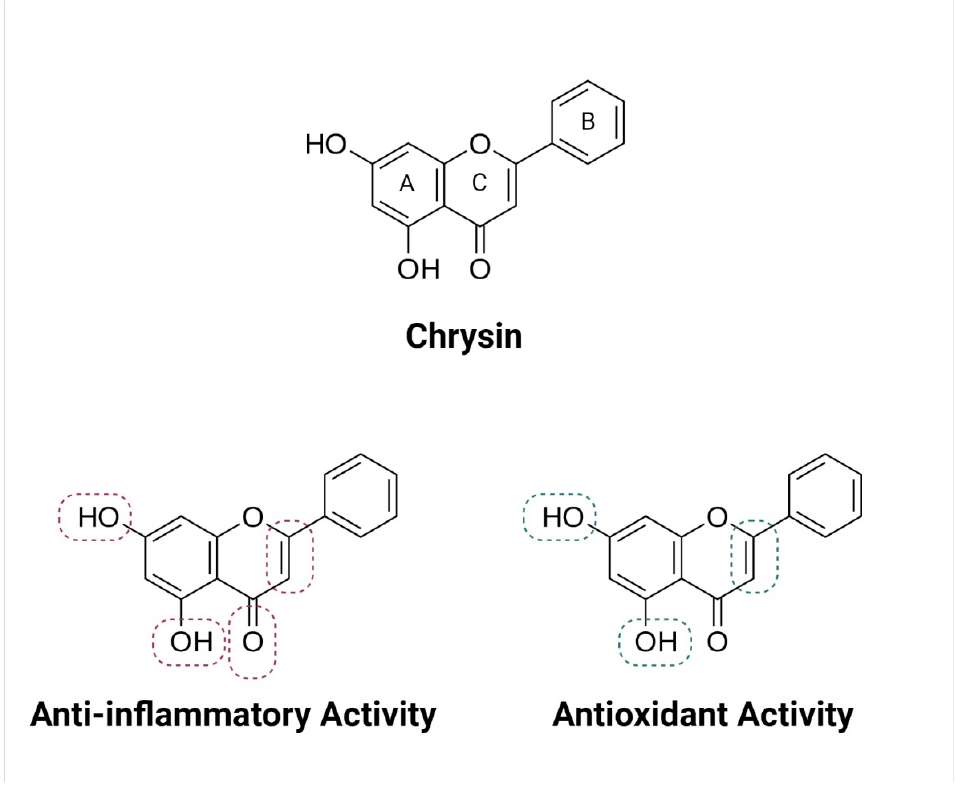
Figure 1. Chemical structure of chrysin and important pharmacophores for anti-inflammatory and anti-oxidant activity.